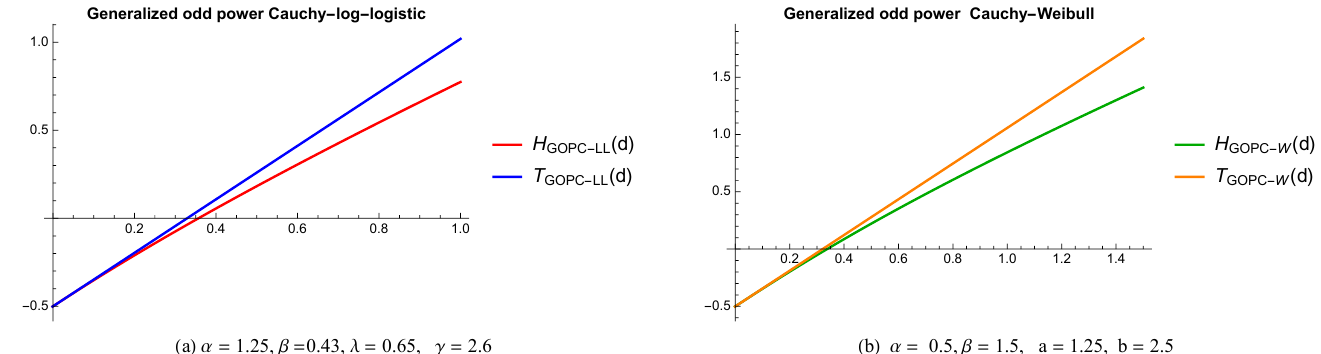
of approximation functions H and T for fixed parameters in the cases of GOPC-LL and GOPC-W distributions.